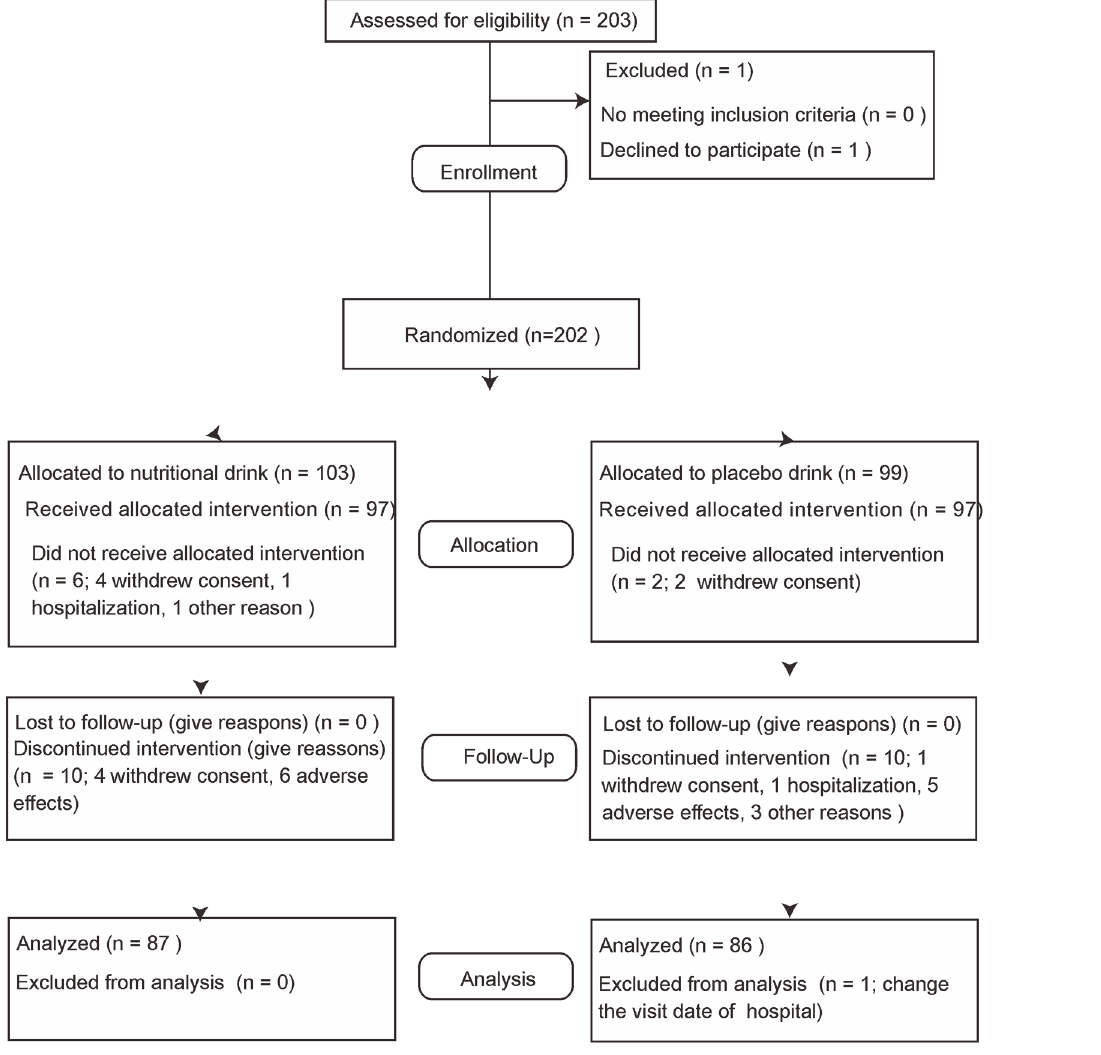
Fig 1. Flowchart of enrollment of randomized control